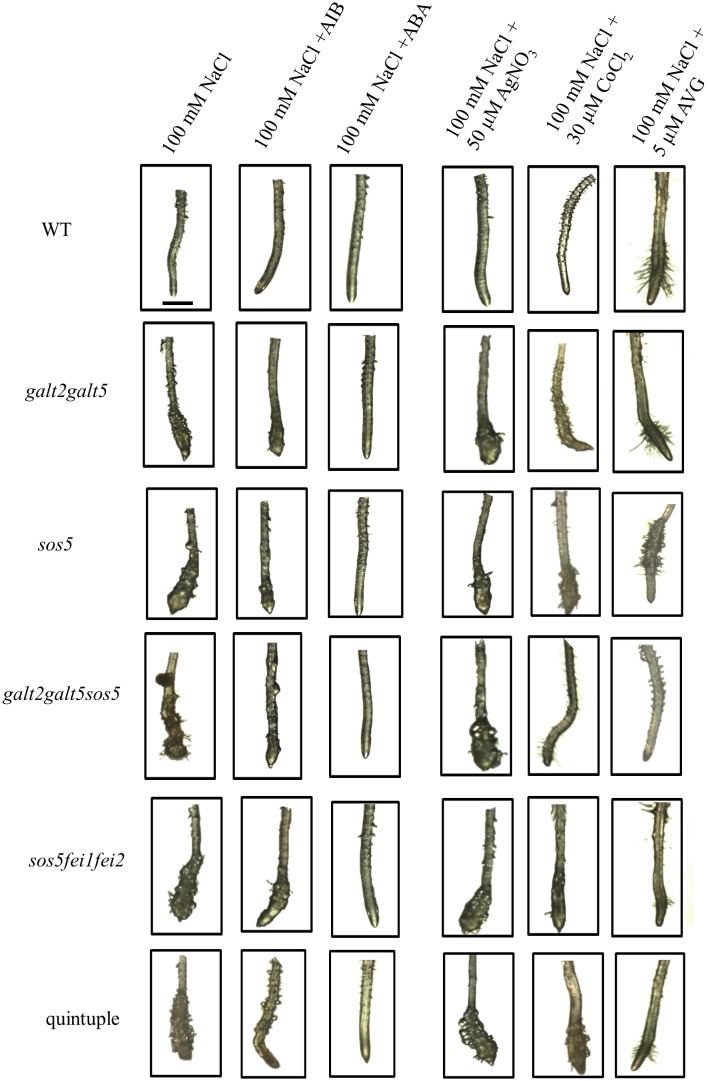
Role of ethylene and ABA on the conditional root swelling phenotype.Images of WT and mutant seedlings grown on MS medium containing 0% sucrose for 4 d and transferred to MS medium containing 100 mM NaCl supplemented with AIB, ABA, AgNO3, CoCl2, and AVG for 7 d as indicated. Scale bar = 1 mm.